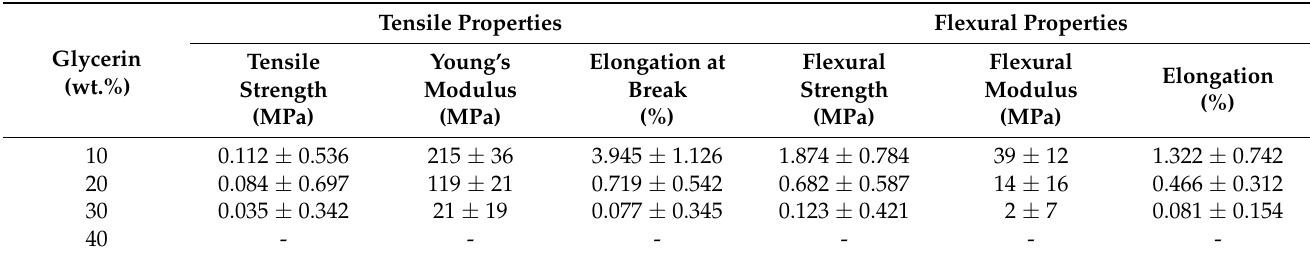
Table 4. Mechanical properties of different thermoplastic lignins (tensile and flexural).